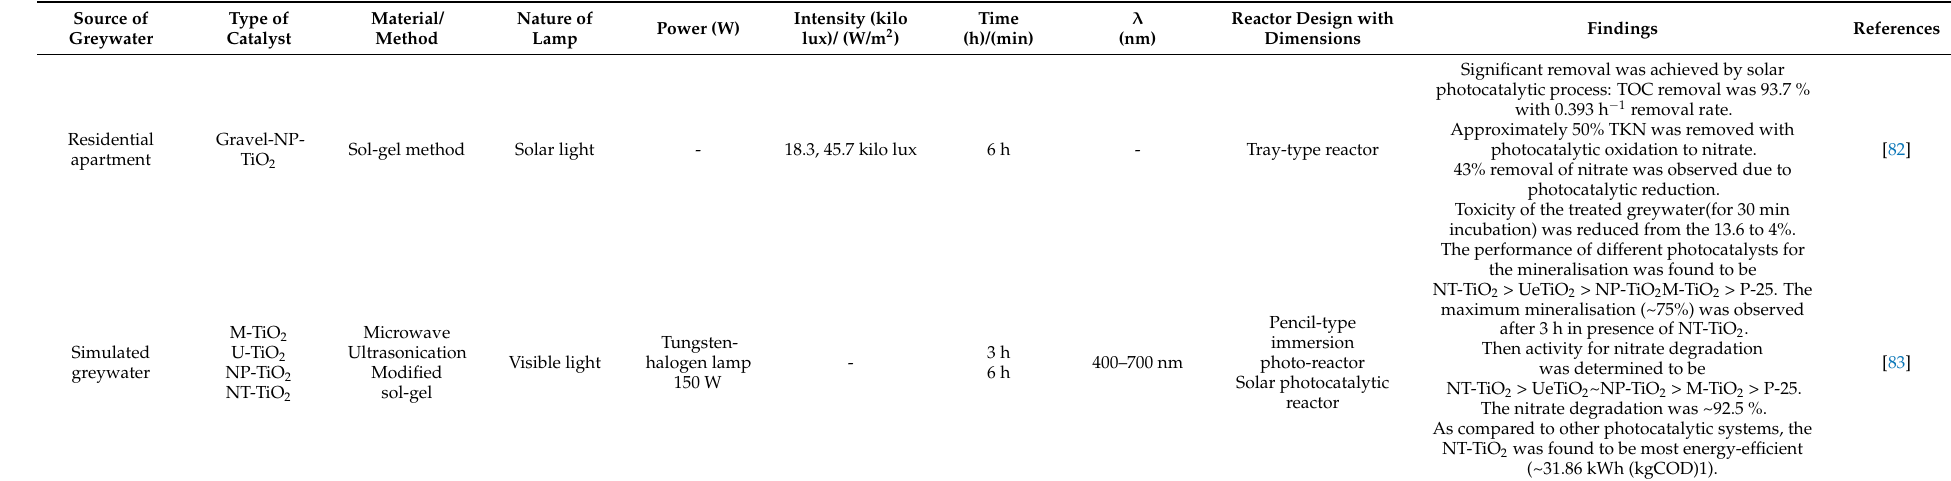
Table 5. Studies showing the photocatalytic treatment of greywater with modified TiO 2 .